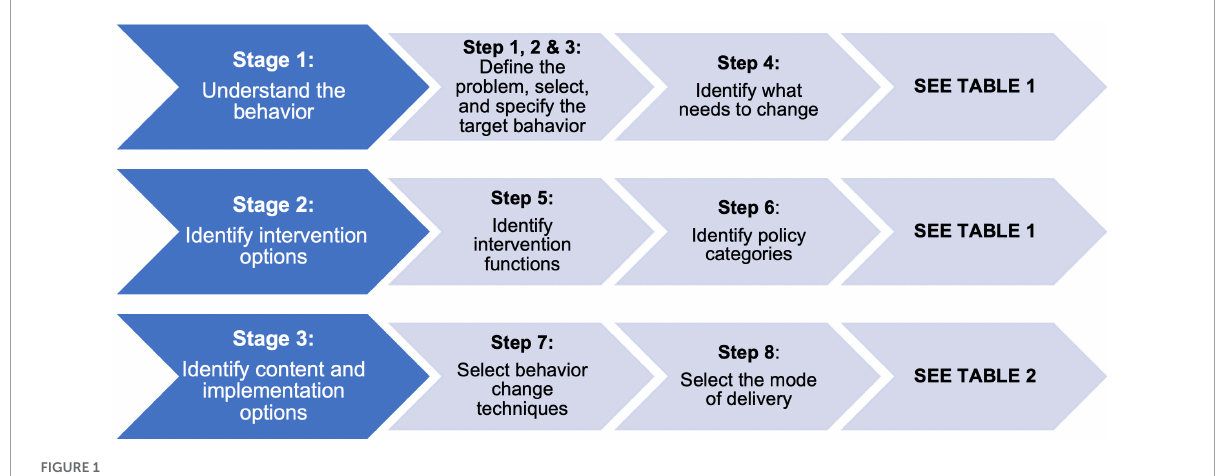
FIGURE1 Behavior Change Wheel stages of intervention